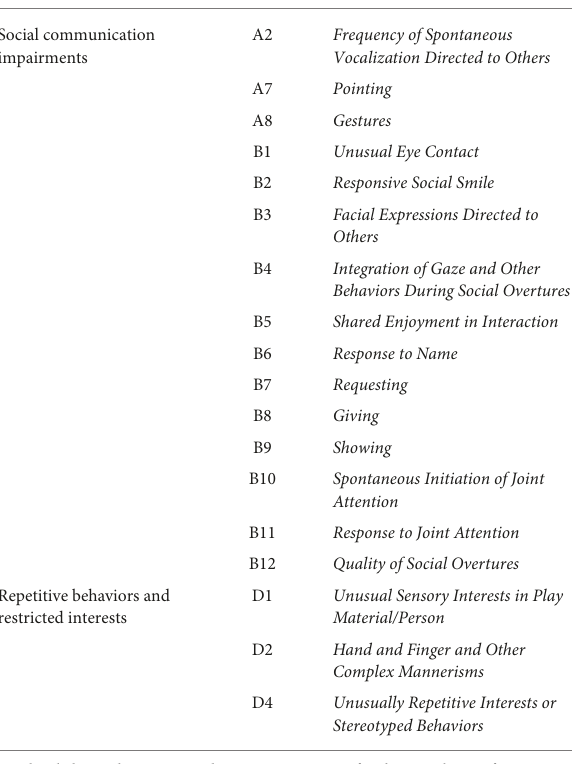
TABLE 2 ADOS Module 1 Items included in the